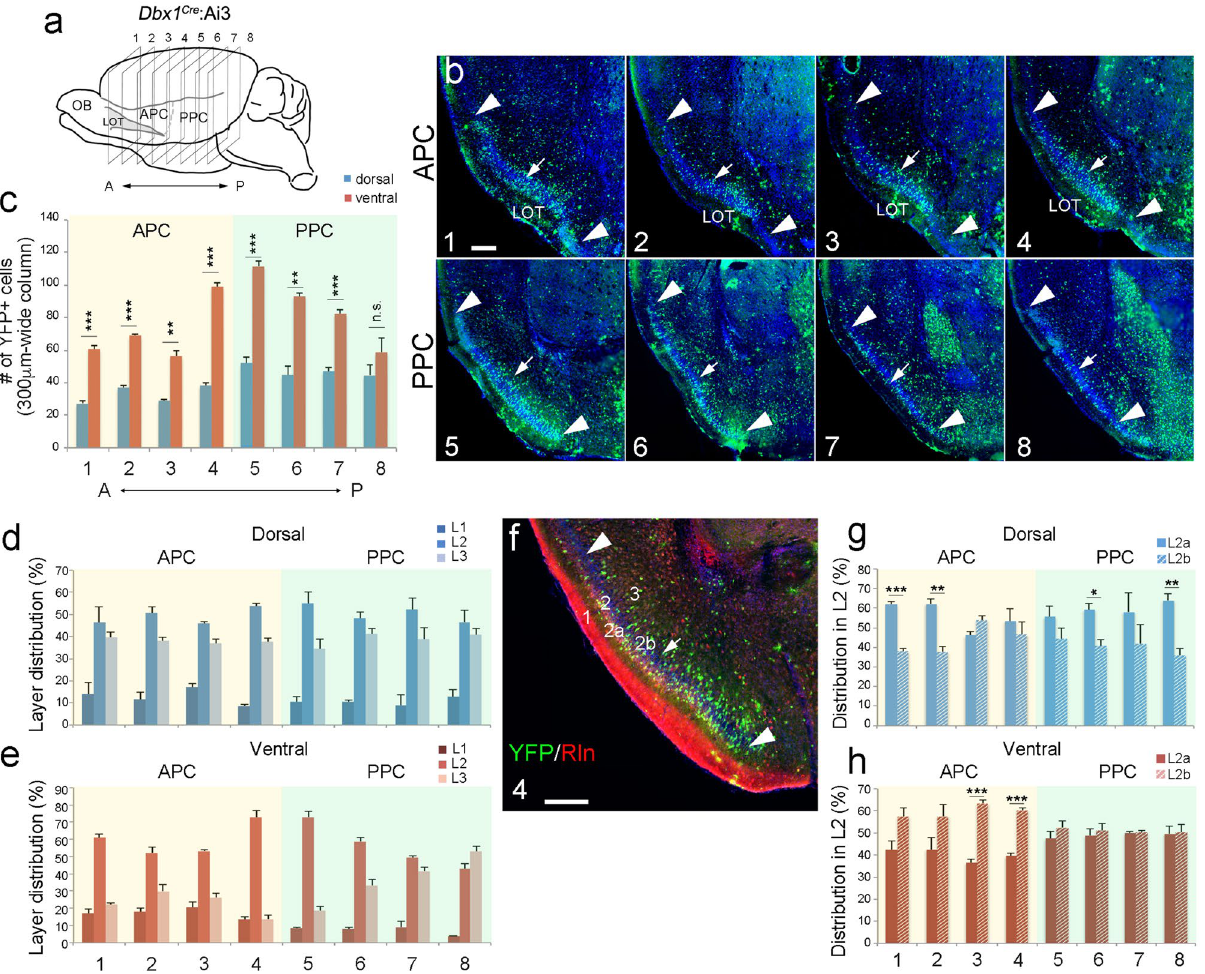
Figure 3. Neurons of the Dbx1 lineage show spatial and laminar distribution preferences in PC. ( a , b ) Coronal sections of Dbx1 Cre :Ai3 cortex at P7 at eight levels from anterior (A) to posterior (P). Arrowheads mark the dorsal and ventral ends of PC and arrow marks the border between dorsal and ventral PC. ( c ) Quantification of the number of YFP-expressing cells in dorsal and ventral PC at each level. Significantly higher numbers of YFP + cells were found in the ventral PC compared to dorsal PC (level 1, p = 0.00036; level 2, p = 1.0085E-05; level 3, p = 0.00165; level 4, p = 2.442E-05; level 5, p = 0.00042; level 6, p = 0.00101; level 7, p = 0.00059; level 8, p = 0.2561; n = 3). ( d , e ) Quantification of laminar distribution of YFP + cells. Most YFP + cells were detected in layer 2 (L2), across the PC. ( f ) Immunostaining for Reelin (red) on coronal section of Dbx1 Cre :Ai3 cortex (at level 4 as in c). Reelin staining is enriched in L2a. ( g , h ) Within L2, the percentages of YFP + cells in L2a and L2b are shown across the PC (n = 3). Scale bar, 100